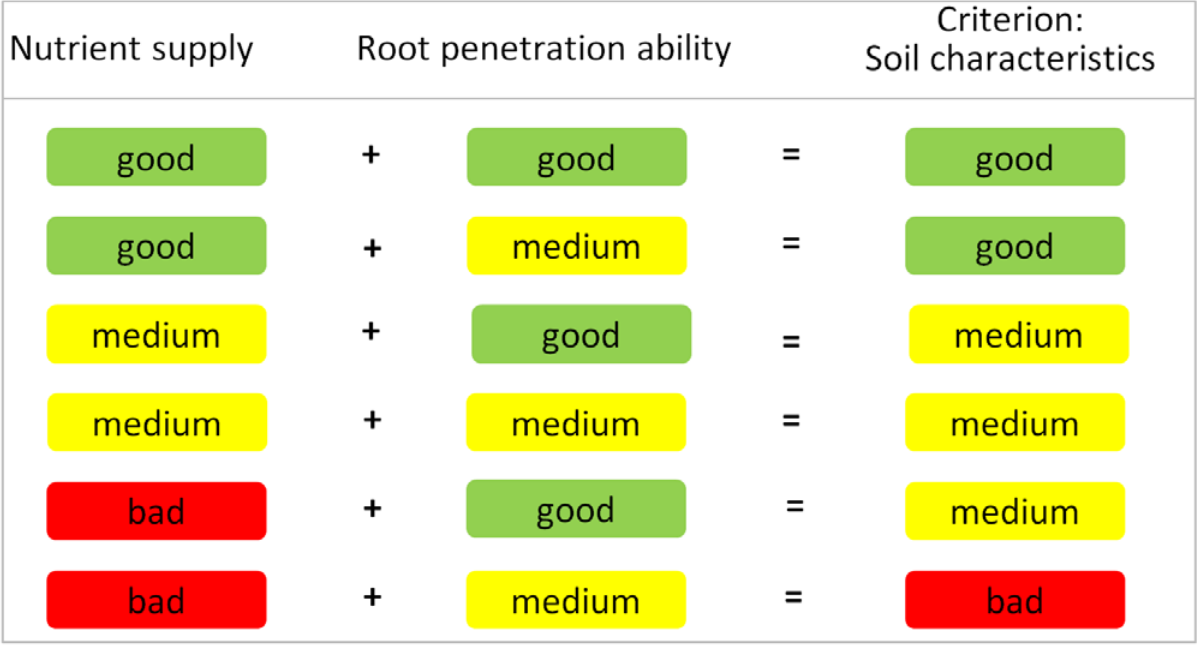
Figure 3. Matrix with logic operation rules for aggregation of the indicators ‘nutrient supply’ and ‘root penetration ability’ to the criterion ‘soil